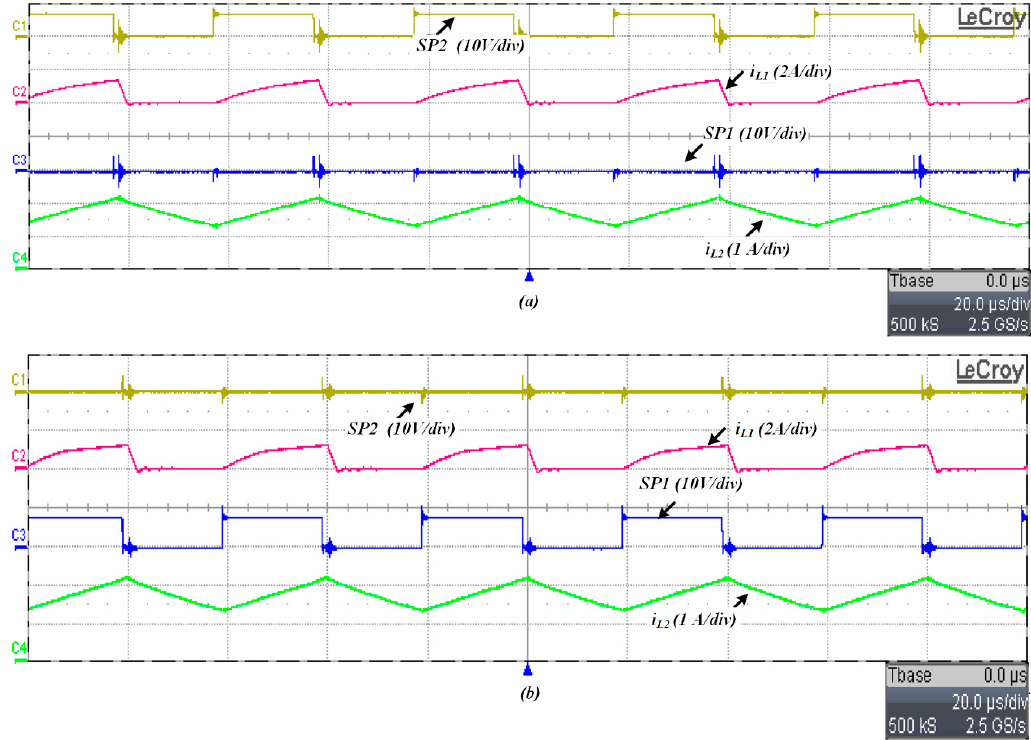
Figure 13. Experimental results for the buck / buck-boost circuit: ( a ) with two switches (Circuit Figure 5, Top) and ( b ) with a single switch (Circuit Figure 5, Bottom).